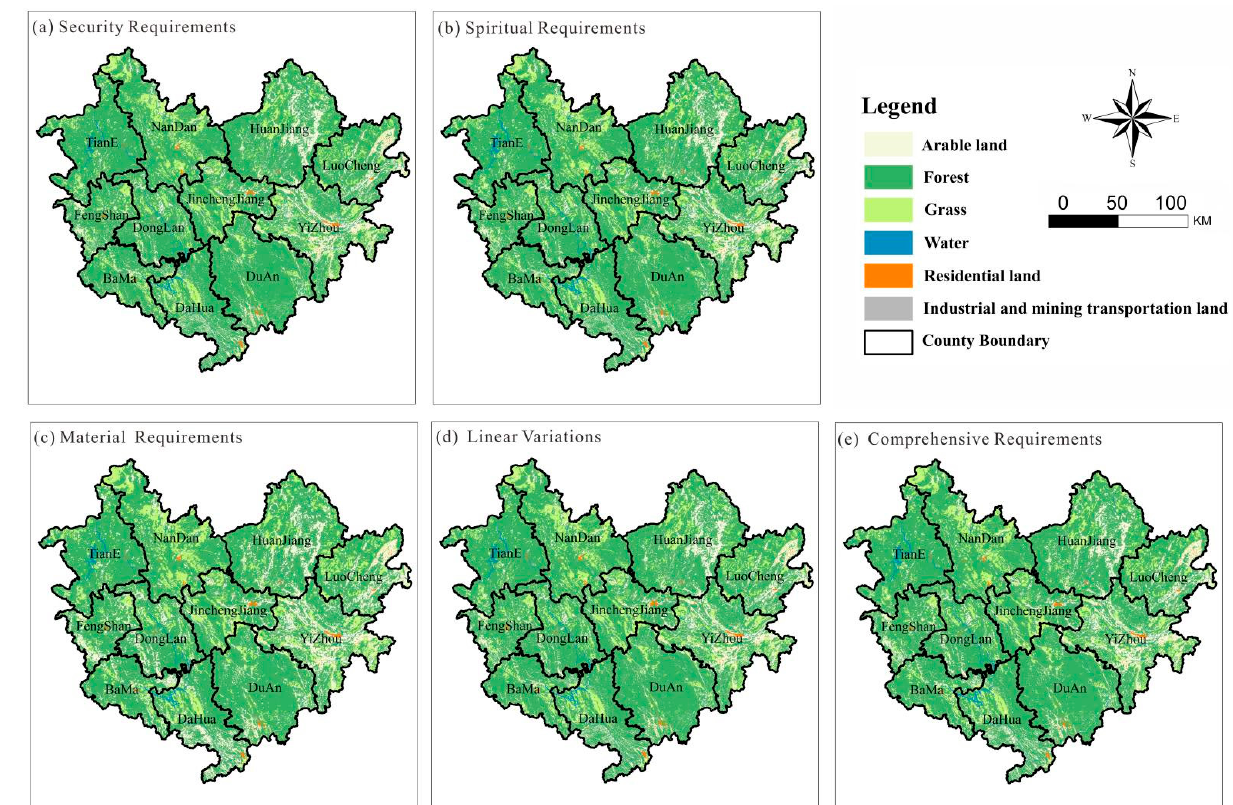
Figure 5. Land use map of Hechi City in 2035 under meeting different human needs goals. ( a ) Security requirements optimization results, ( b ) Spiritual Requirements optimization results, ( c ) Material requirements optimization results, ( d ) Linear variations optimization results, ( e ) Comprehensive Requirements optimization results.